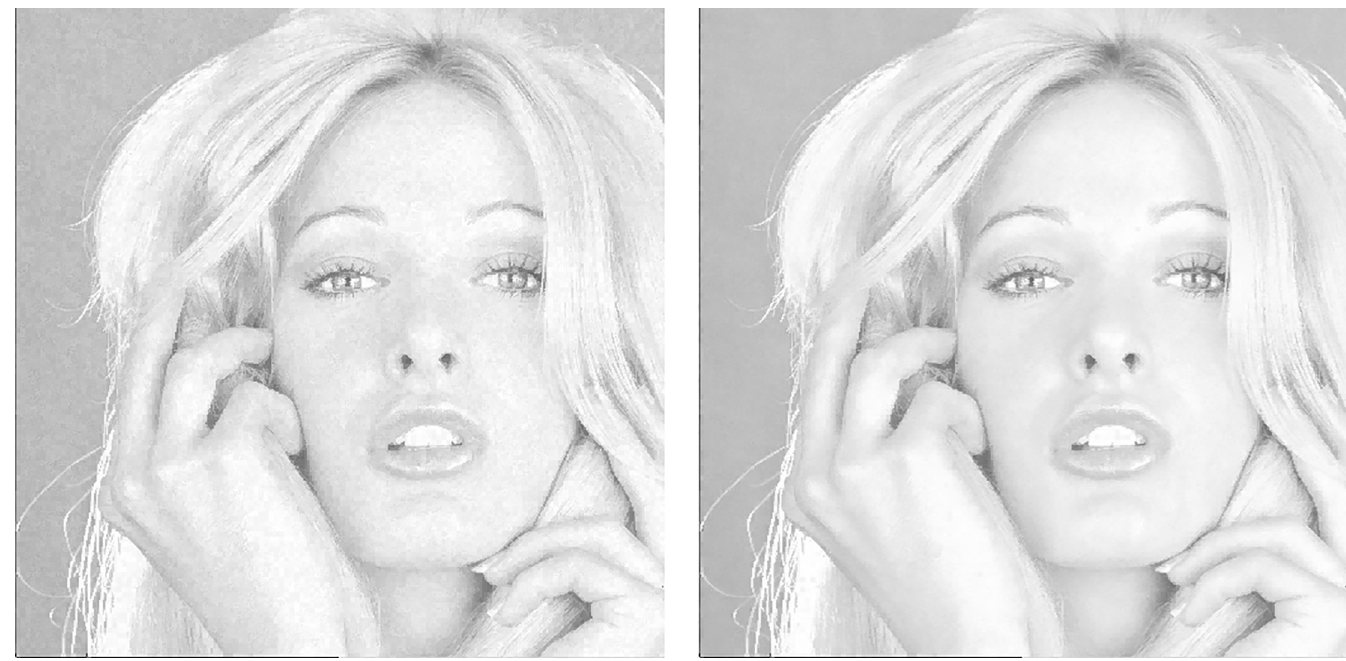
Fig 8. Image quality comparisons when using and without using the BTT. (a) Without BTT, PSNR = 34.89 dB. (b) With BTT, PSNR = 39.42 dB.